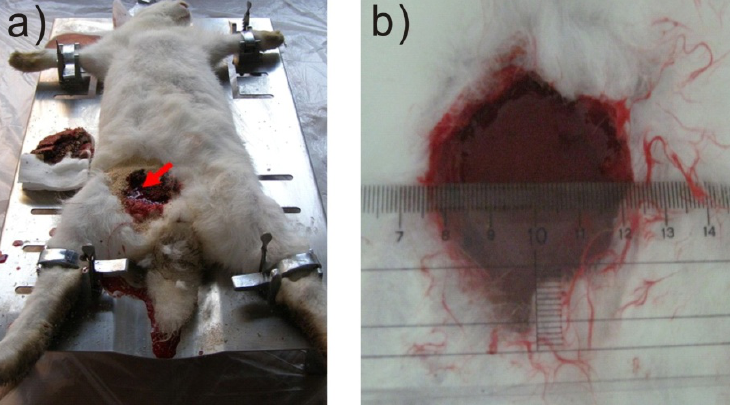
Figure 3. The lethal rabbit model with complex groin injury. ( a ) The wound applied with the Quikclot. Hemostasis was achieved after 3 min oppression; ( b ) The Wound applied with medical gauze, blood is oozing after removing medical gauze. The wound is around 4 cm long and 1 cm